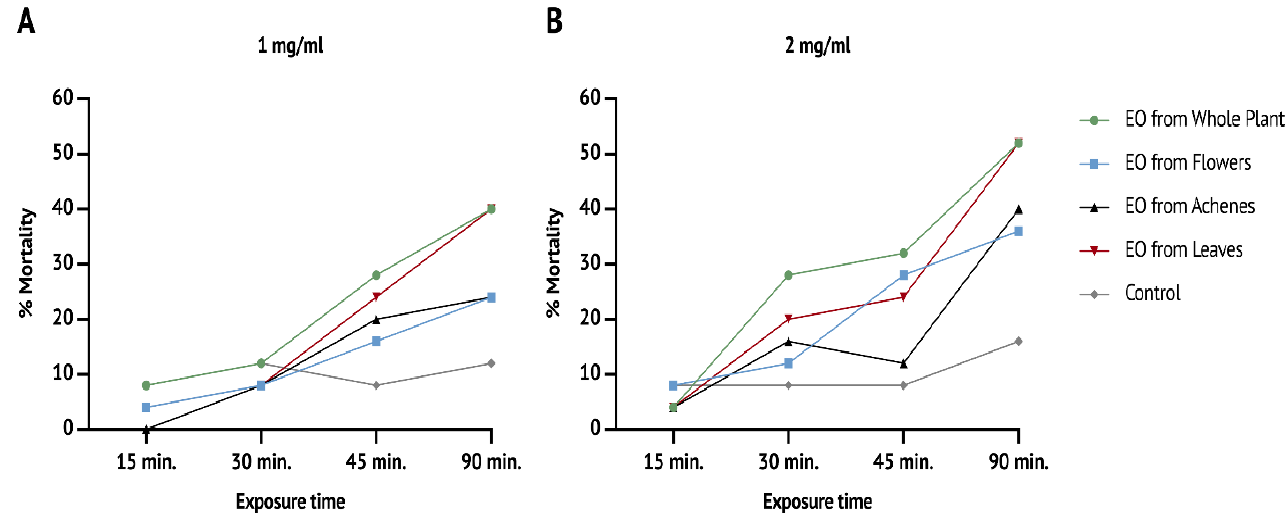
Figure 1. Mortality rates reached after 15, 30, 45 and 90 min of exposure to EO vapours at ( A ) 1 mg/mL concentration and ( B ) 2 mg/mL concentration. Table 2. Mortality percentages obtained after 15, 30, 45 and 90 min of exposure to EO vapours. Time of